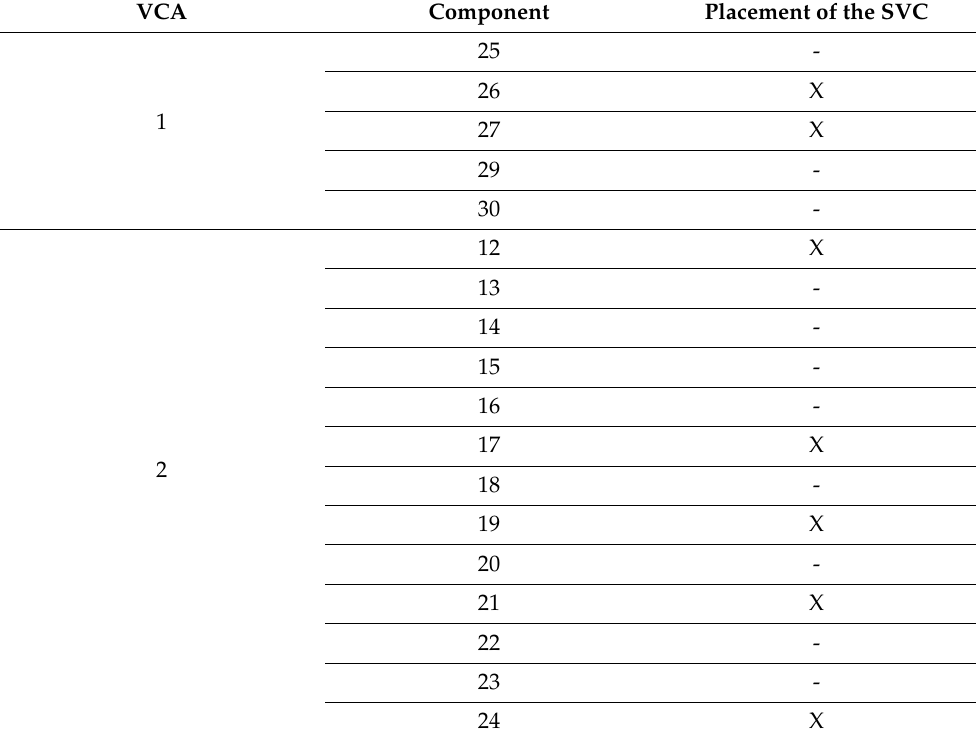
Table 3. Resulting VCAs for the 30-node test